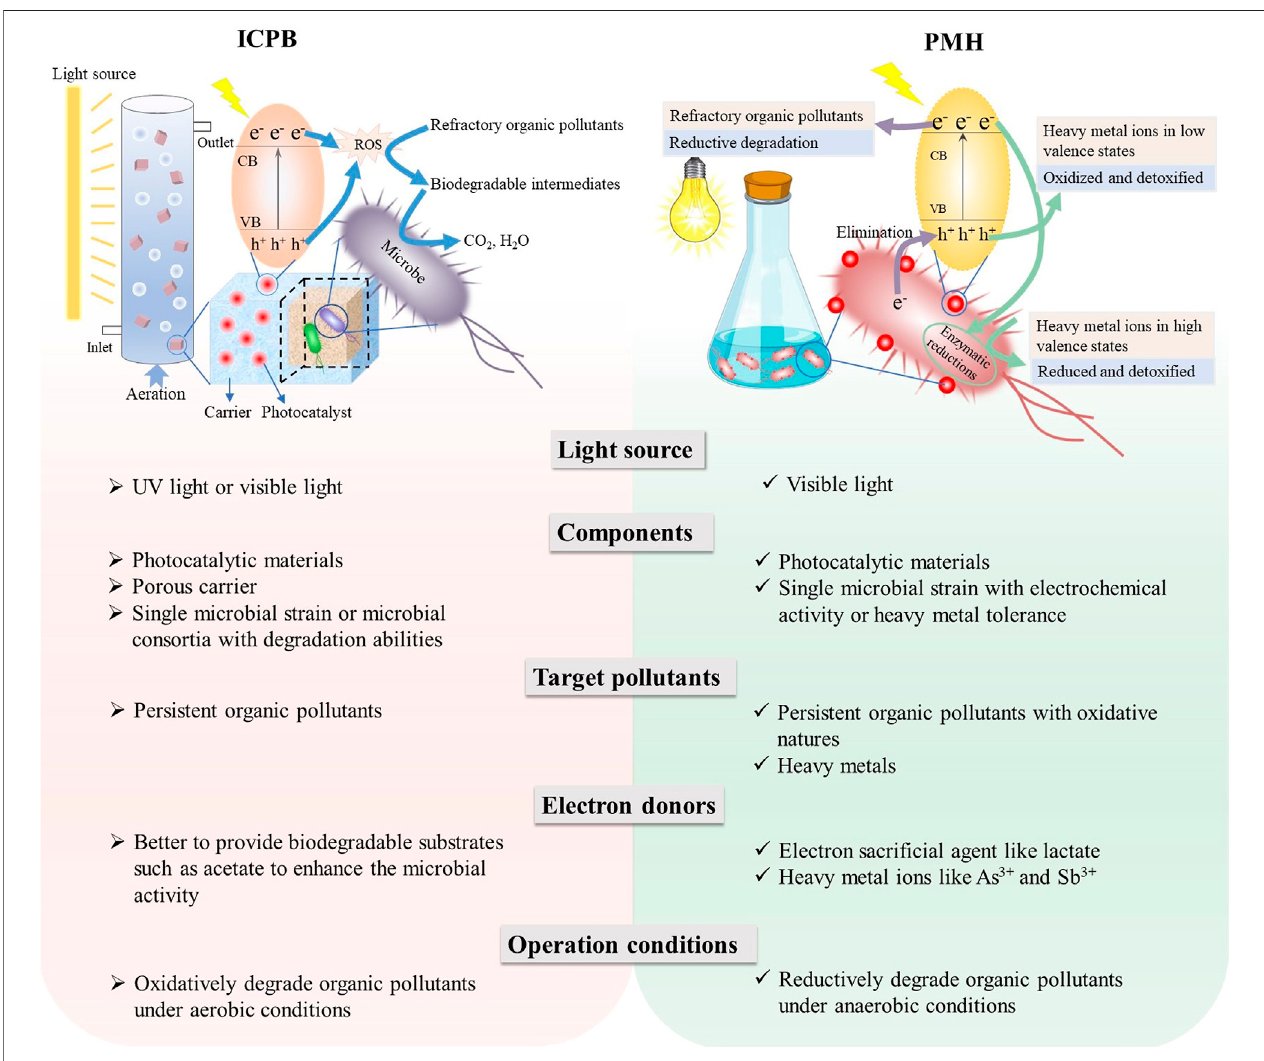
FIGURE 2 | Comparisons between the ICPB system and PMH